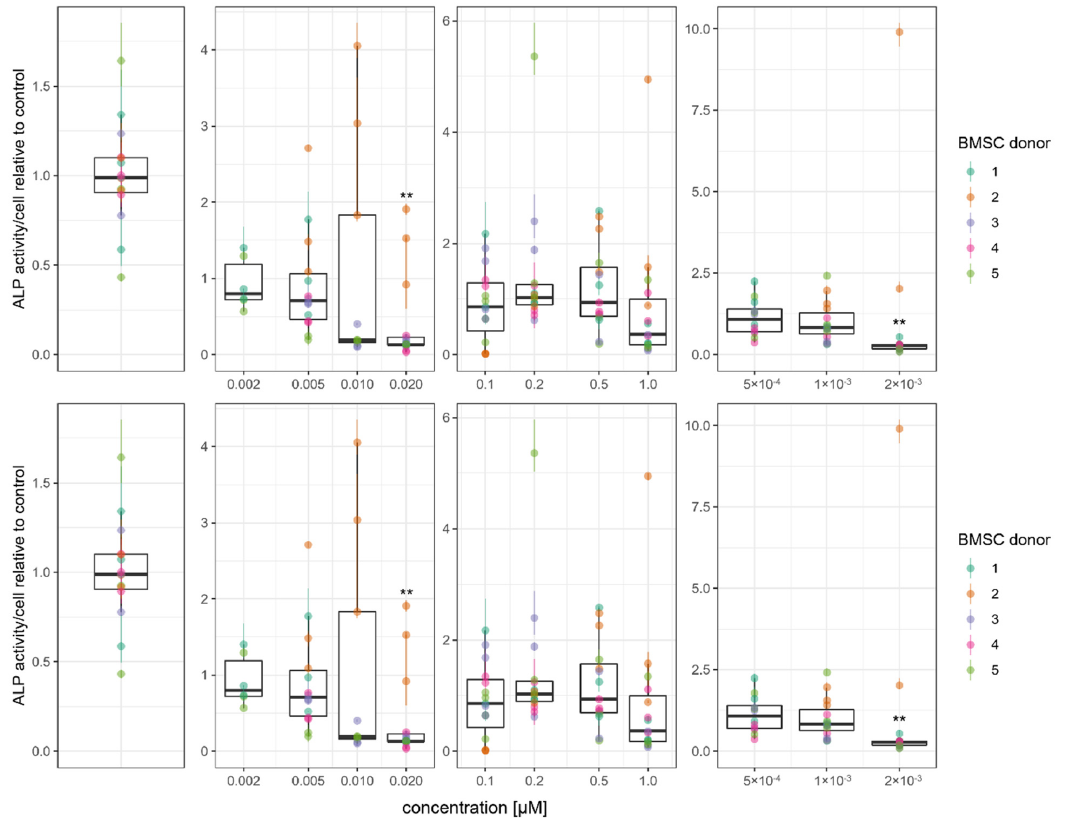
Figure 9. Drug effect on bone formation in osteogenically differentiated BMSCs. Alkaline phosphatase (ALP) activity of BMSCs at 21 days of culture in osteogenic differentiation conditions with melflufen, melphalan, and doxorubicin added at indicated concentrations. ALP activity is normalized by total cell number and is presented relative to the control. Dots represent individual culture wells with a color-coded donor cell line. OM, osteogenic medium control without drugs. ** denotes p < 0.01 with Dunn’s test.